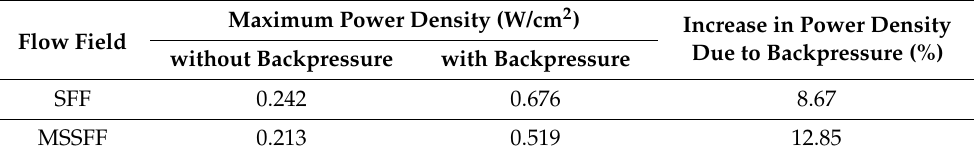
Table 2. Effect of backpressure on power density in 25 cm 2 PEMFC with SFF and MSSFF. Flow